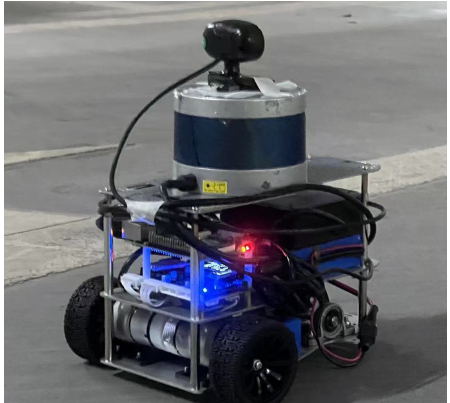
Figure 21. The mobile robot.